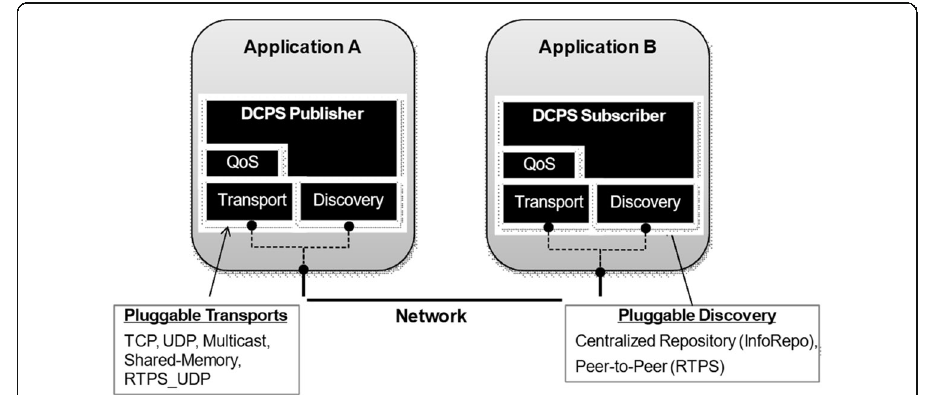
Fig. 2 OpenDDS extensible Transport Framework (Computing O. Inc.